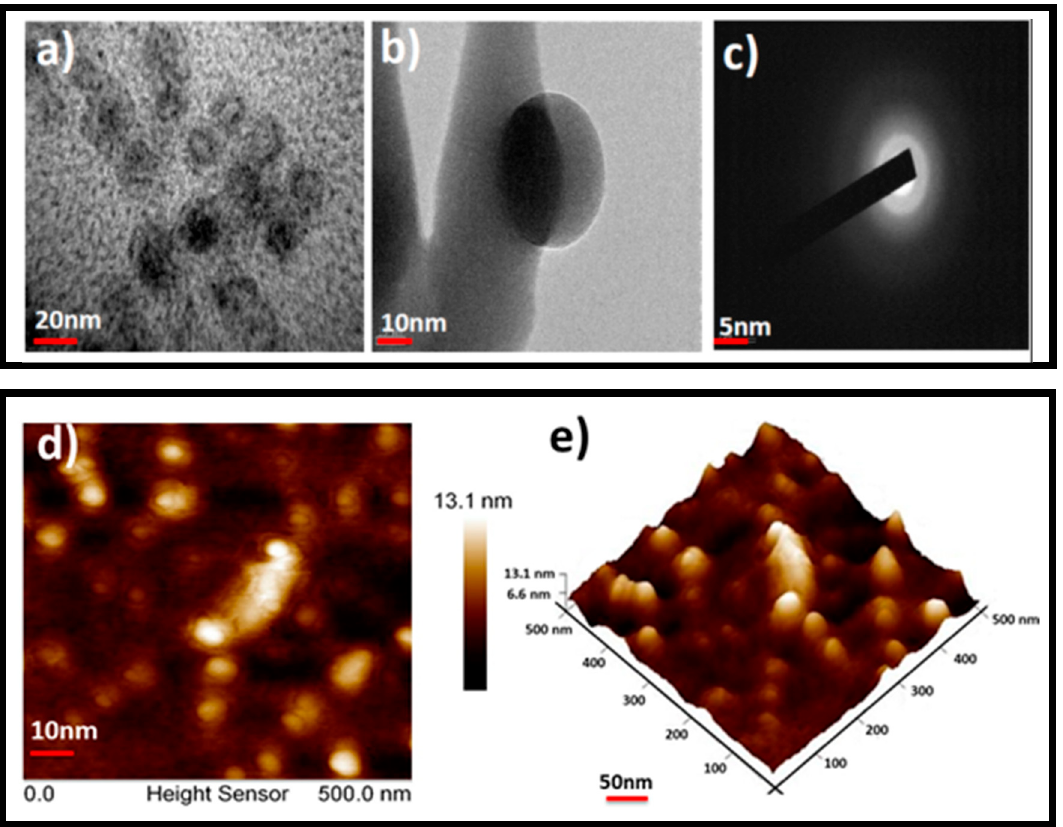
Figure 2. HRTEM images of synthesized GOQDs ( a ) Low magnification (scale bar, 20 nm). ( b ) High magnification (scale bar, 10 nm). ( c ) The electron diffraction pattern recording. ( d ) AFM of synthesized GOQDs and its 3-D imaging profile. ( e ). The AFM was recorded at the length of 500 nm. After morphological and physical structural conformation from electron microscope